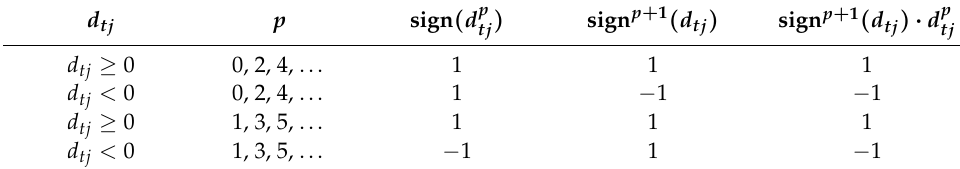
Table 1. Finite signed measure in Equation (24) preserves the sign of d tj